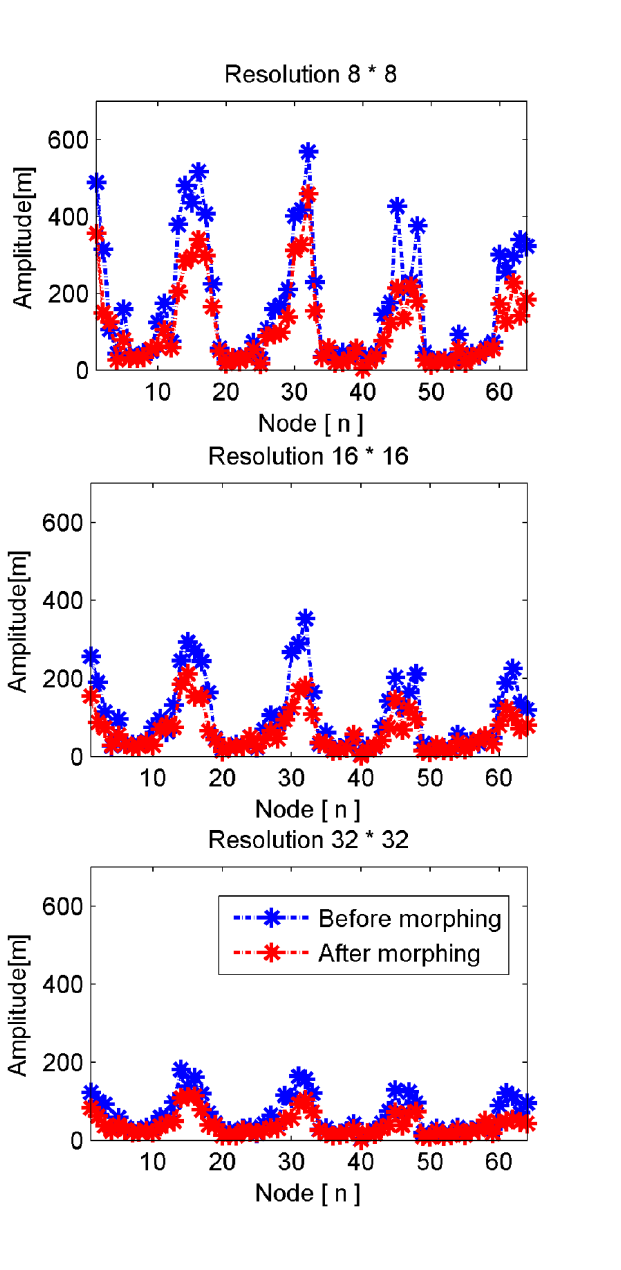
Figure 7. Comparison between the mean square error before and after applying the